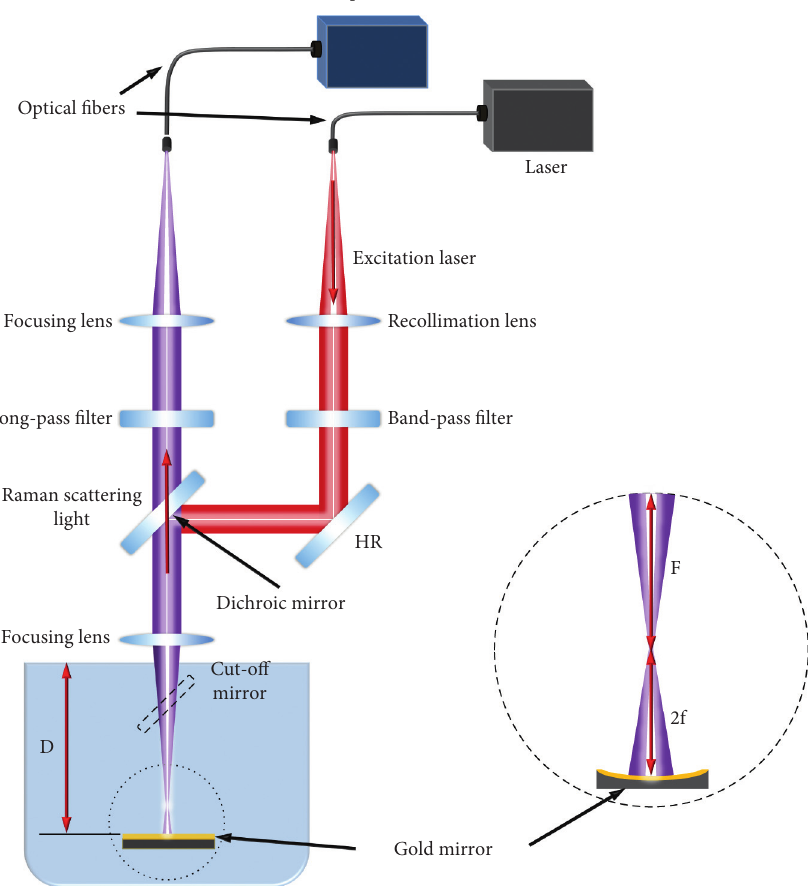
Figure 1: Experimental setup for optical feedback-enhanced Raman spectroscopic measurements on liquid